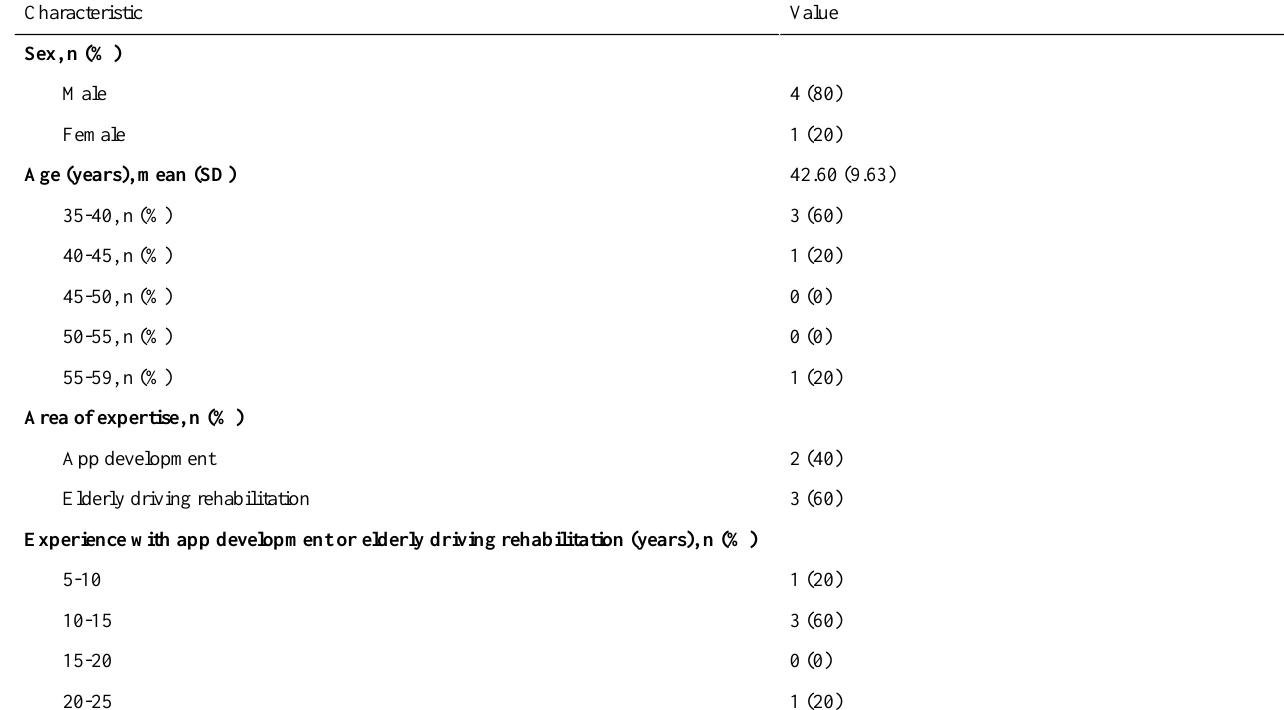
Table 1. General characteristics of the focus group